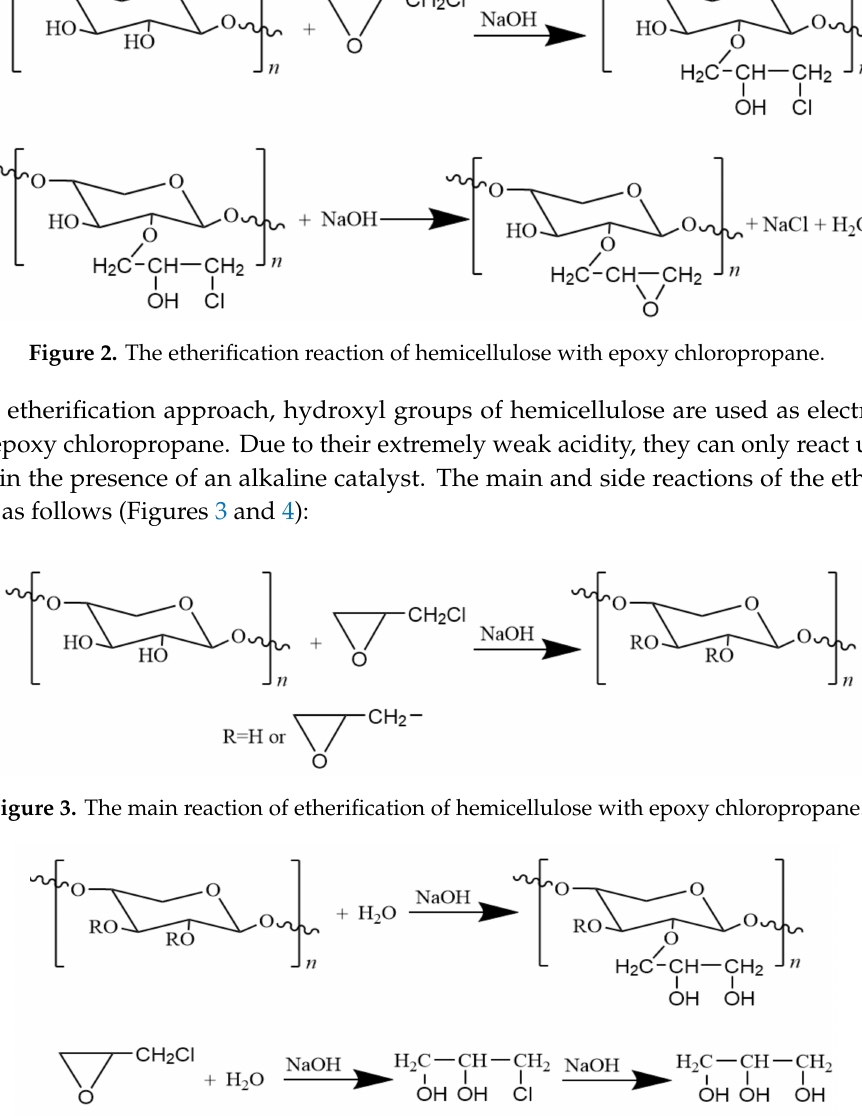
Figure 4. The side reactions of etherification of hemicellulose with epoxy